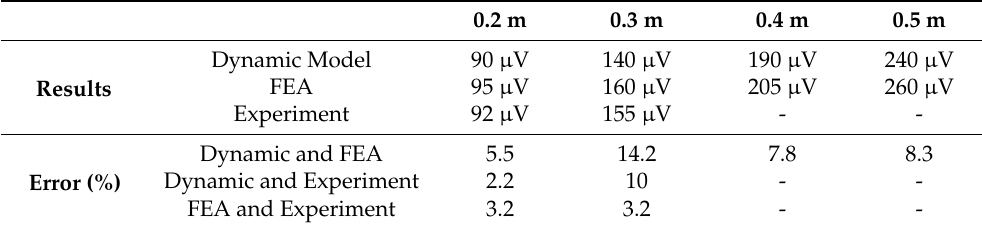
Figure 12. Comparison of the results of the dynamic model (Red line), FEA simulation (Blue line), and experiment (Orange line): ( a ) Results for 0.2 m wave height; and ( b ) Results for 0.3 m wave height. Table 2. Comparison of the results.